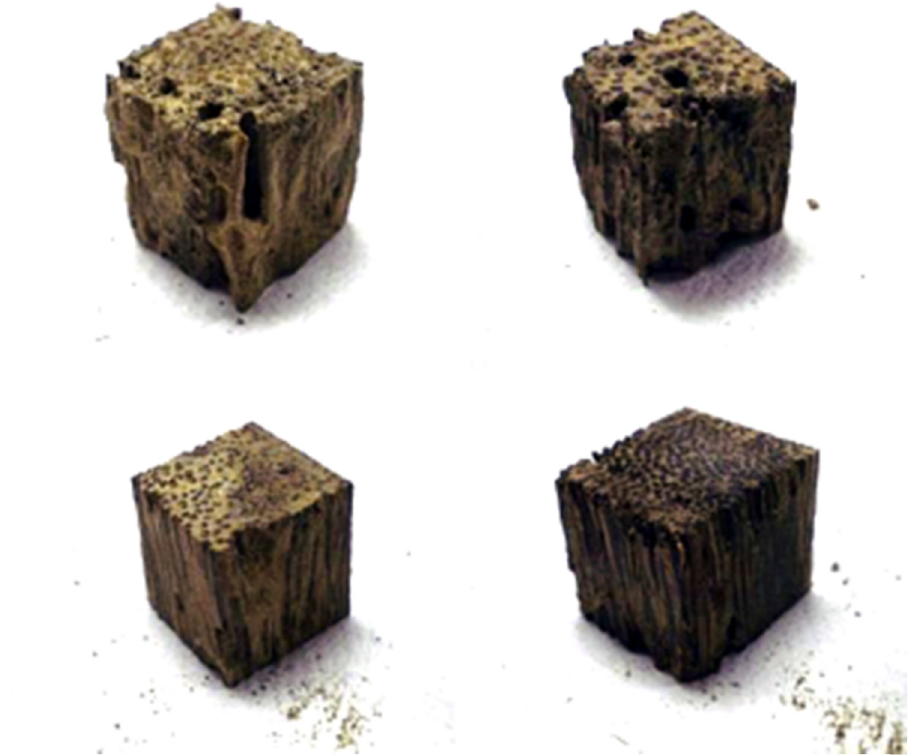
Figure 8: OPW after cleaning at the end of the termite test. Top left: untreated OPW; top right: treated OPWD - 0%; bottom left: treated OPWD - 25%; and bottom right: treated OPWD - 50% [ 76 ] .